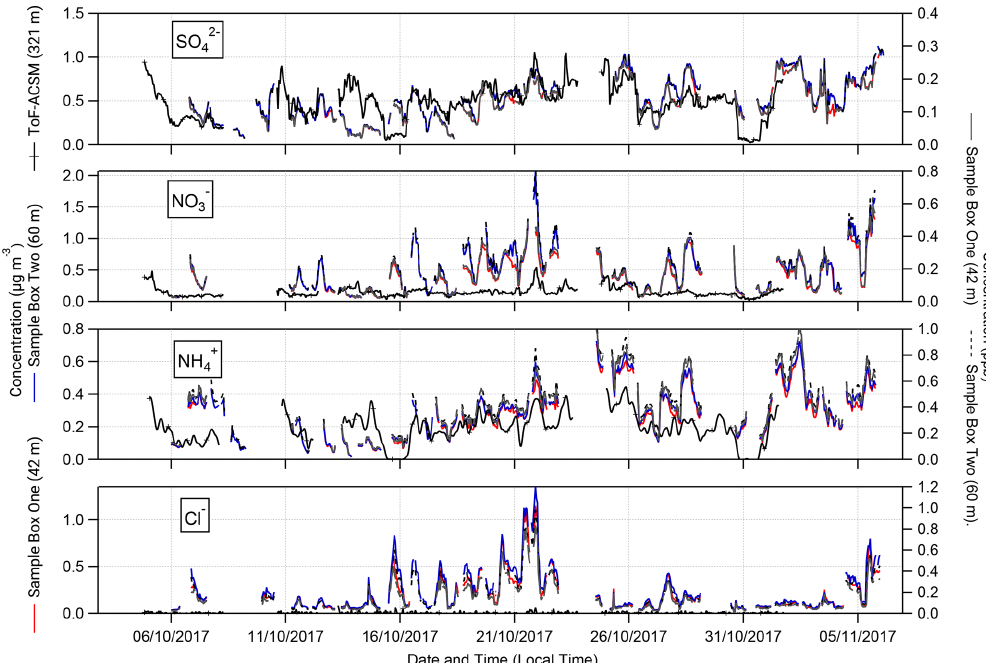
Figure 3. Time series of hourly concentrations (primary left axis, mass concentrations; secondary right axis, molar mixing ratios) of water- soluble aerosol species measured by GRAEGOR at 42m (red, mass concentration; solid black line, molar mixing ratio) and 60m (blue, mass concentration; dashed grey line, molar mixing ratio) on the 80m tower, as well as ToF-ACSM at 321m (black) at the Amazon tall tower, at the Amazon Tall Tower Observatory